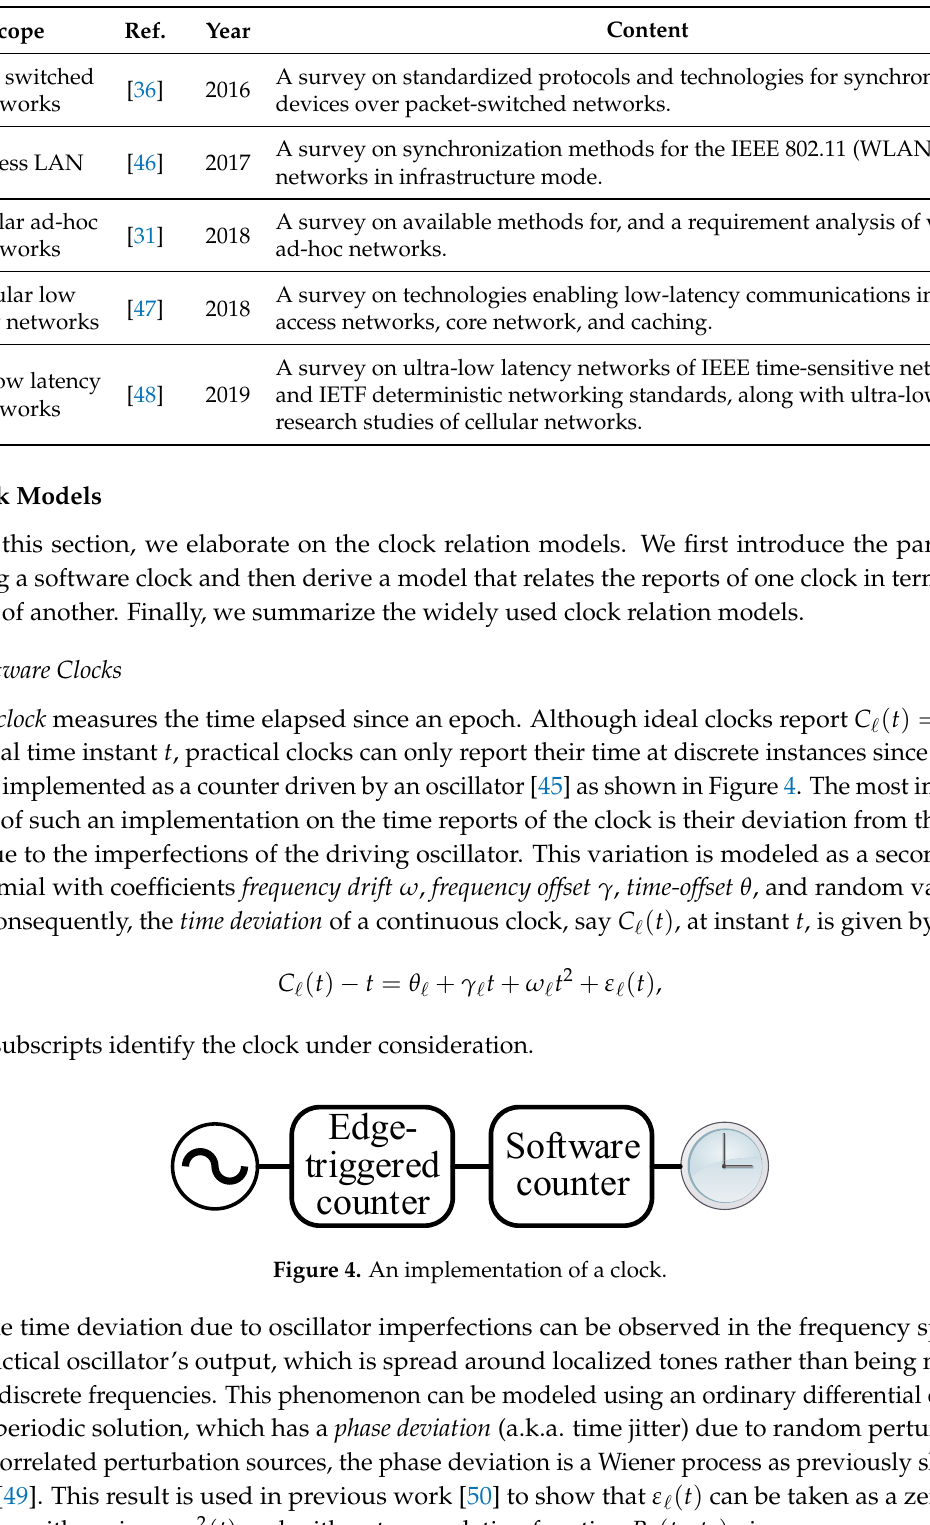
Table 2. Surveys on time synchronous networking.